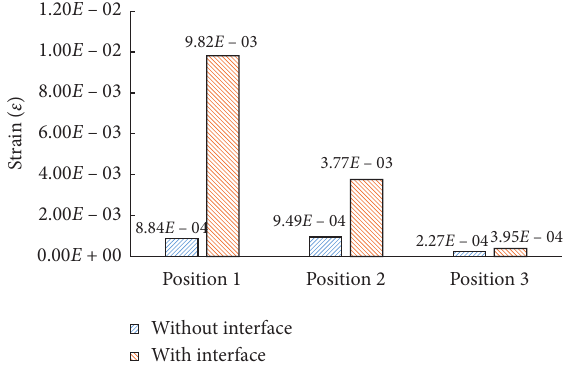
Figure 10: Histogram of strain at three key